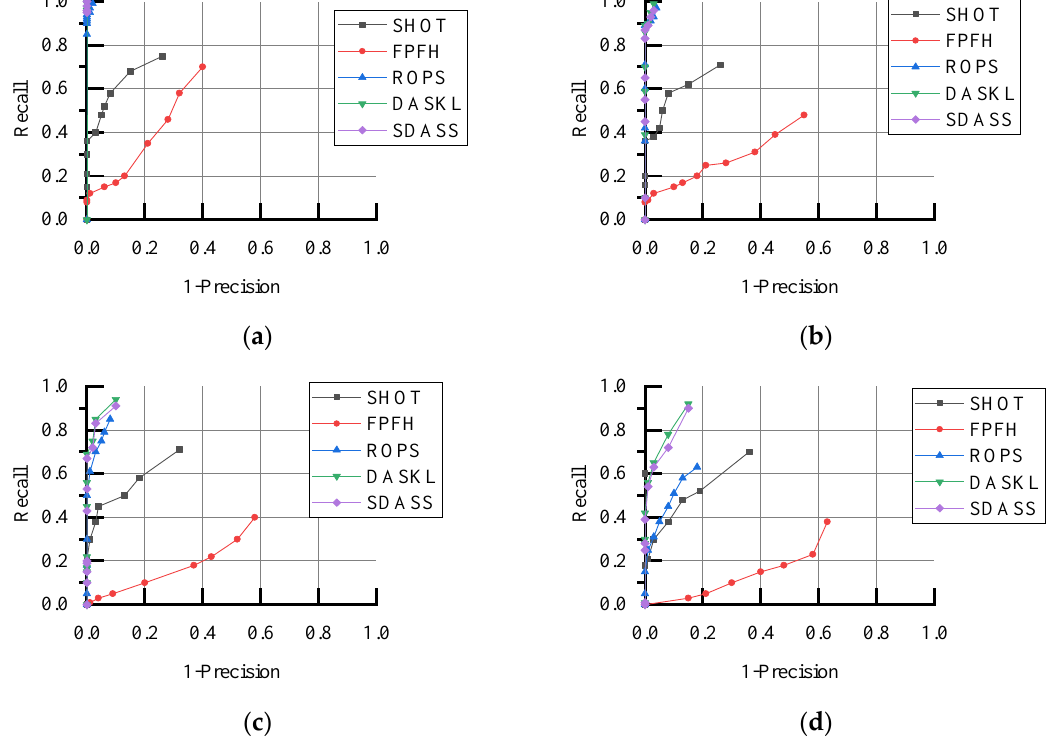
Figure 7. Comparison of feature matching performance under different levels of noise. ( a ) Noise free. ( b ) Noise with a standard deviation of 0.1 mr. ( c ) Noise with a standard deviation of 0.3 mr. ( d ) Noise with a standard deviation of 0.5 mr.